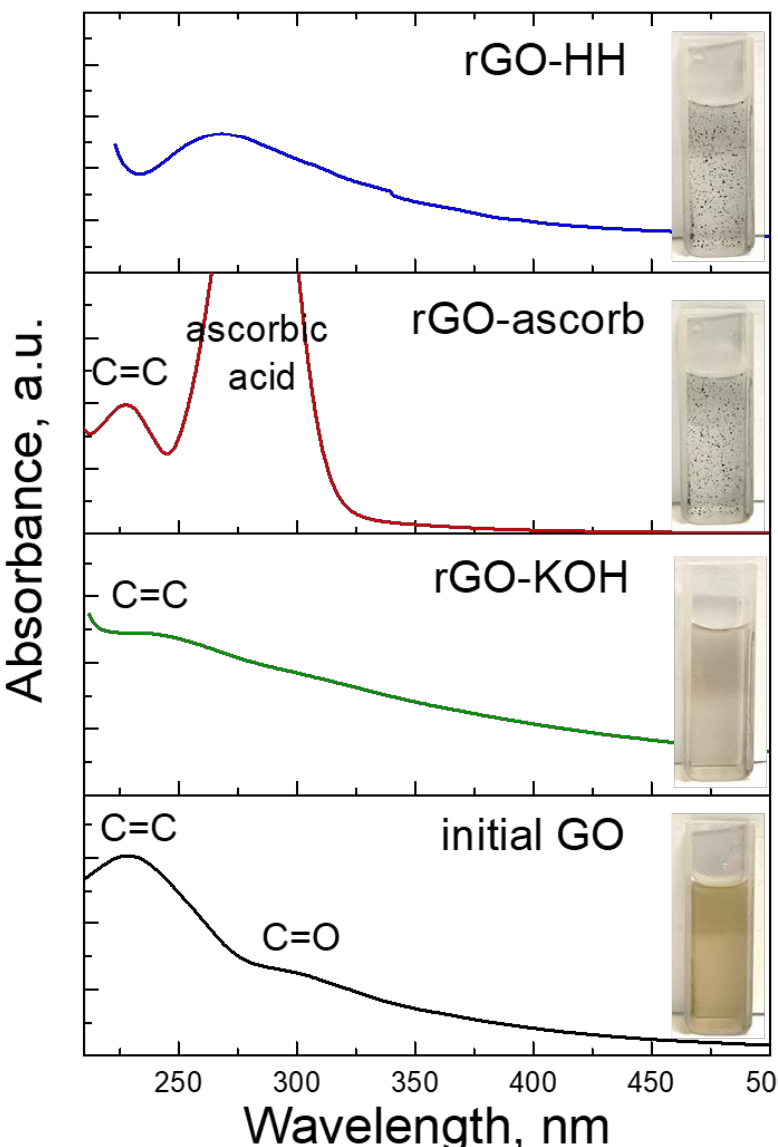
Figure 2. Absorption spectra of rGO–HH, rGO–ascorb, rGO–KOH and initial GO suspensions. The inset shows photographs of the obtained colloidal solutions. The full-scale data for rGO–ascorb are presented in Figure S3.